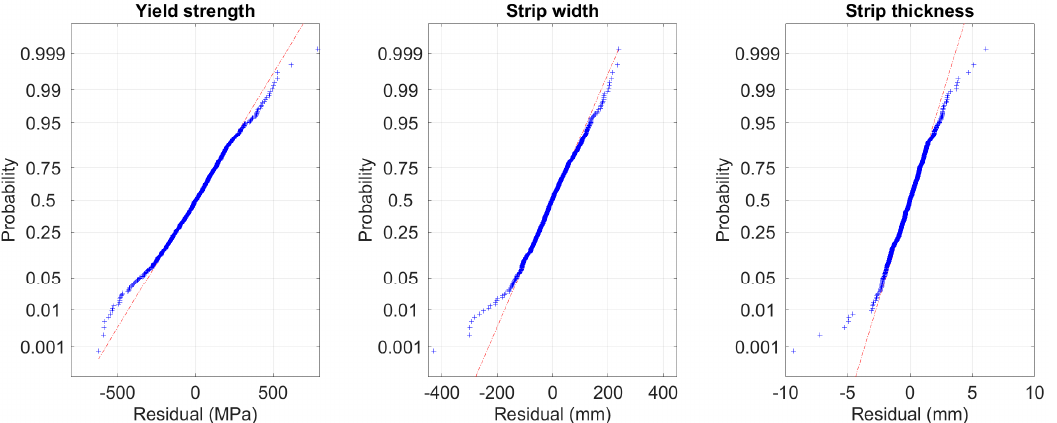
Figure 13. Normal probability plots of the residuals based on models fitted on the remaining 690 points after the removal of narrow and thin strips. Table 7. RMSE and R xy criteria ( µ ± σ ) in cross-validation (CV) and external validation sets for each strip property by using multiple linear